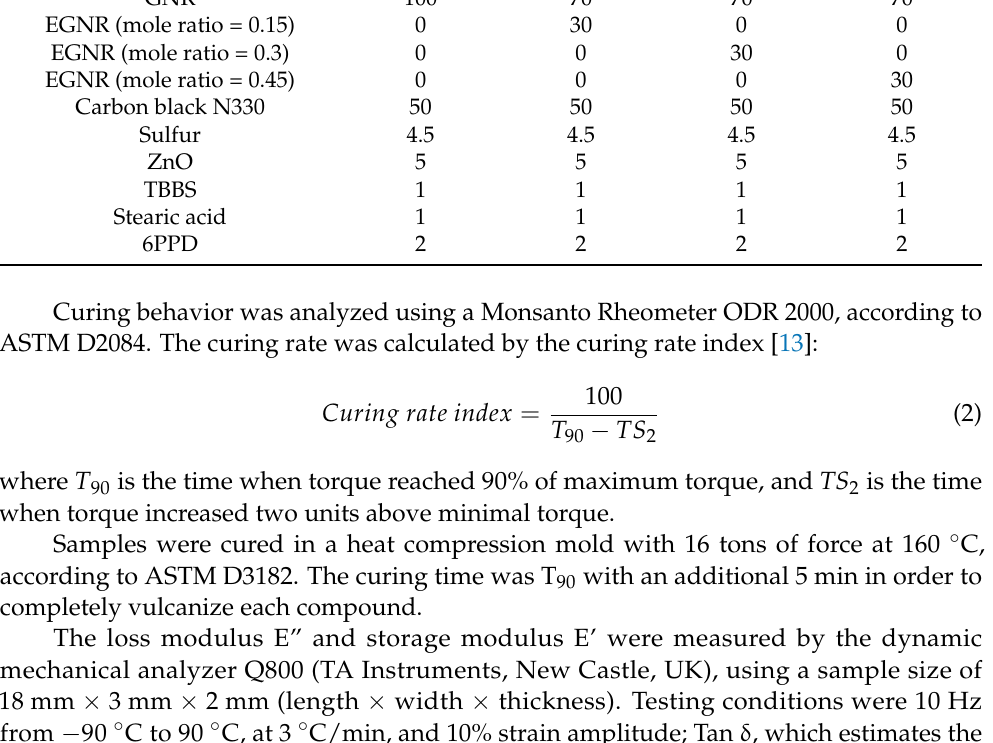
Table 1. Rubber compound formulae.